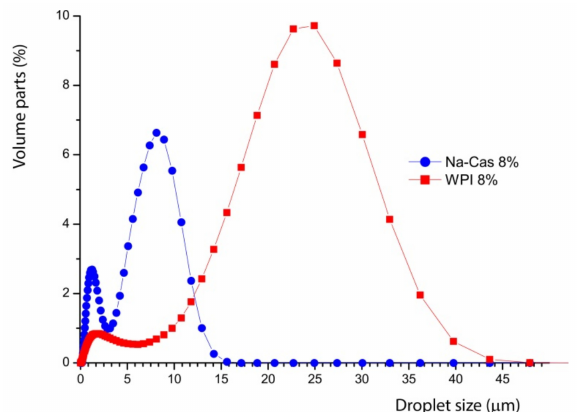
Figure 5. Oil drop size distribution of emulsion consisting of water and 73% oil emulsified with Na-Cas (blue) and WPI (red).